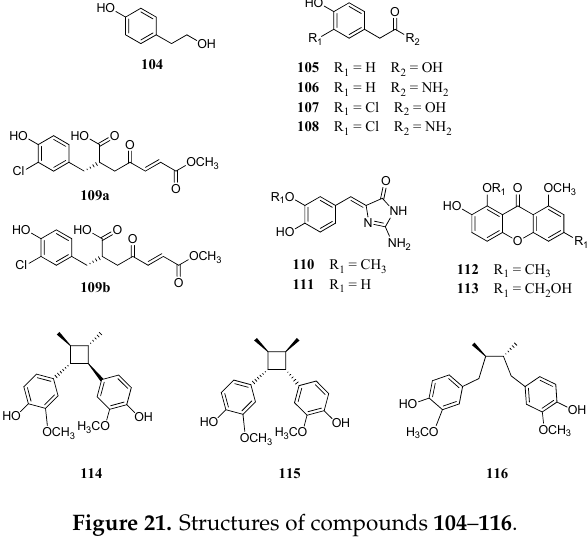
Figure 21. Structures of compounds 104 – 116 .